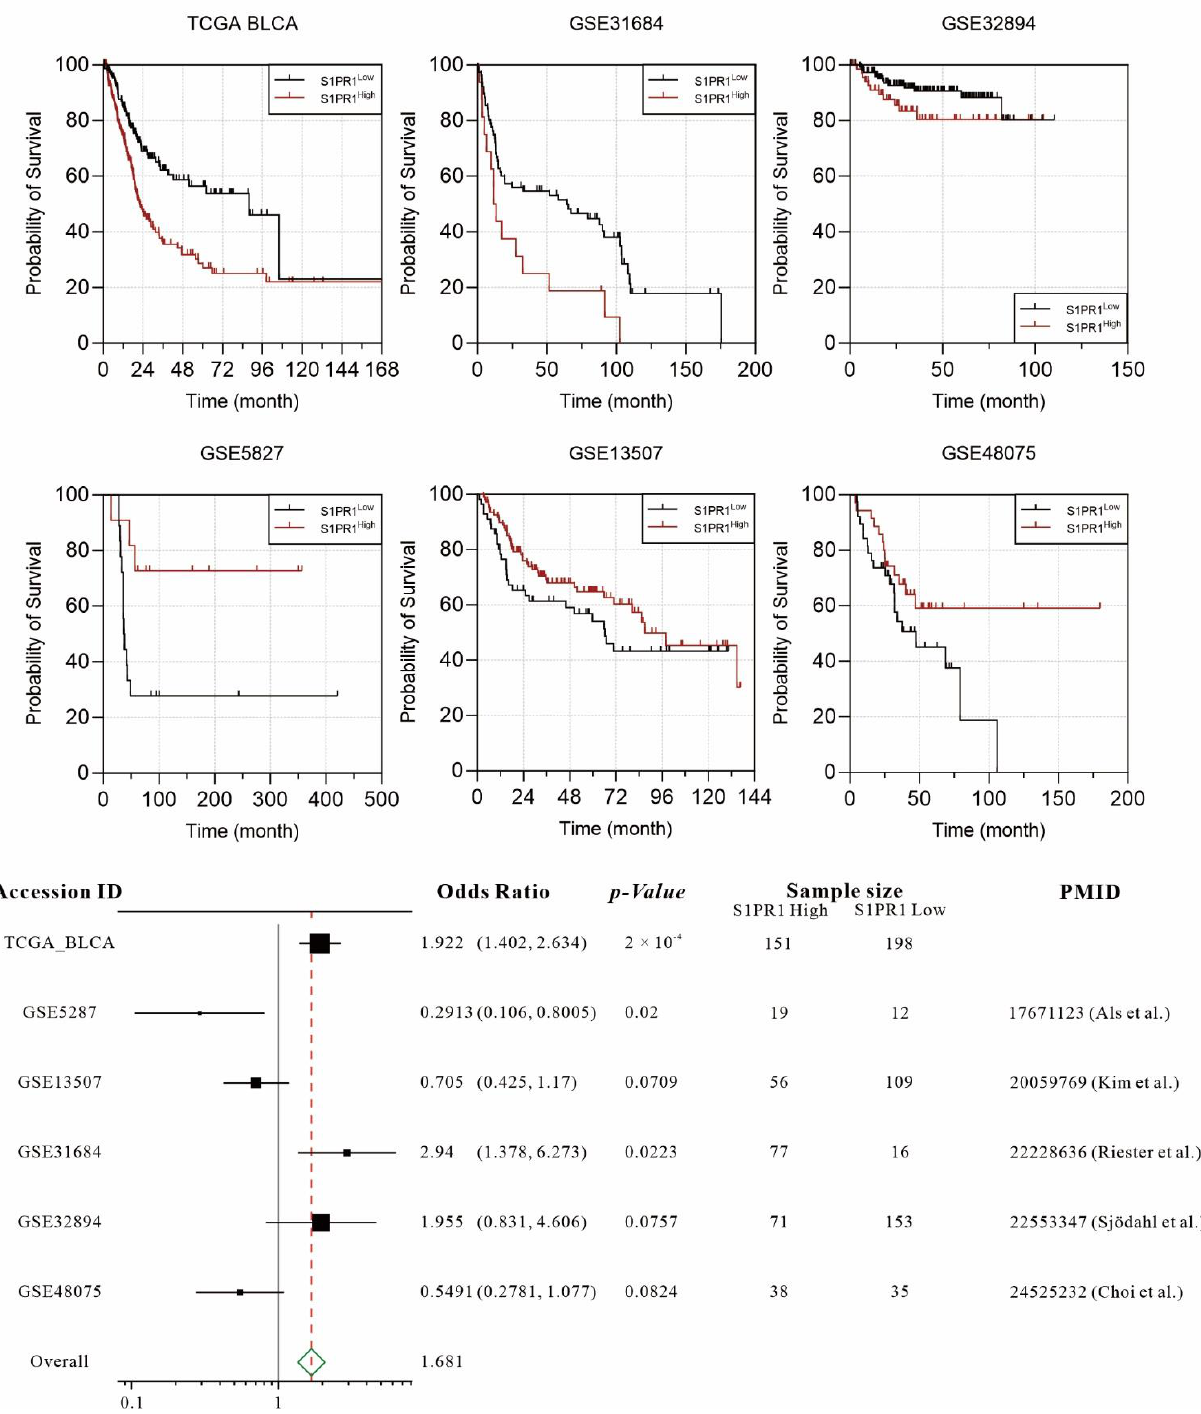
Figure 1. Individual and integrated analysis of the association between S1PR1 mRNA expression and patient prognosis in published bladder cancer clinical databases [30 – 34] .